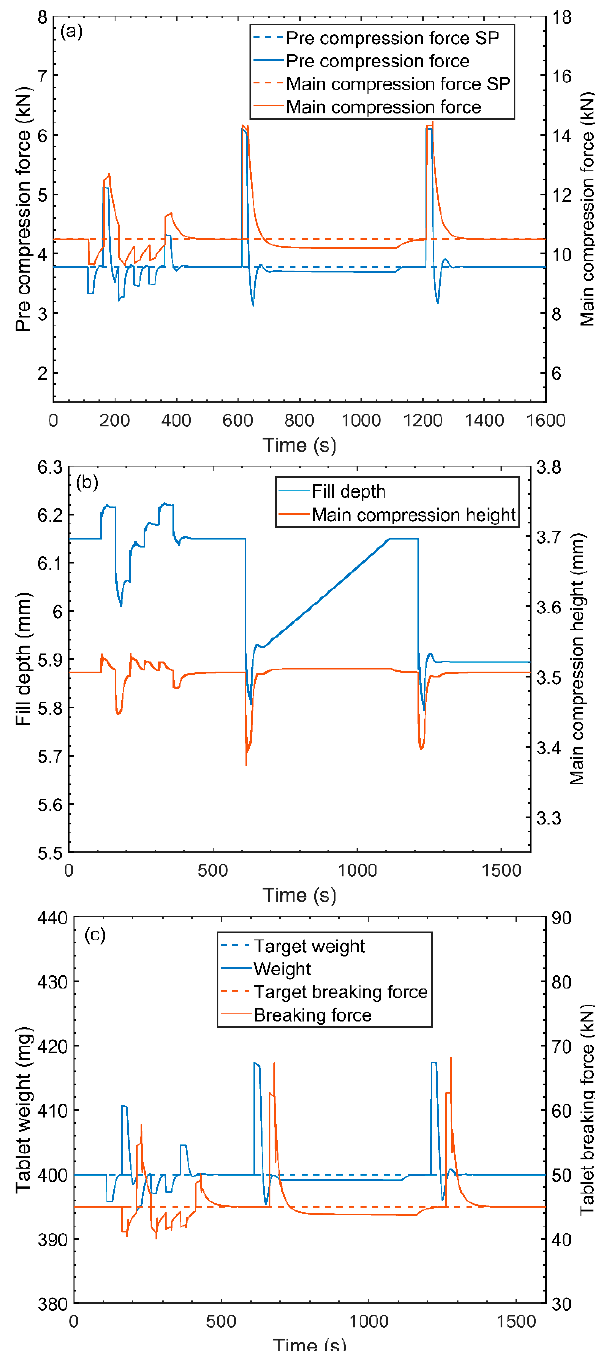
Figure 12. Control strategy 1—Disturbance rejection scenario. ( a ) Critical process parameters ( b ) Actuators ( c ) Critical quality attributes.